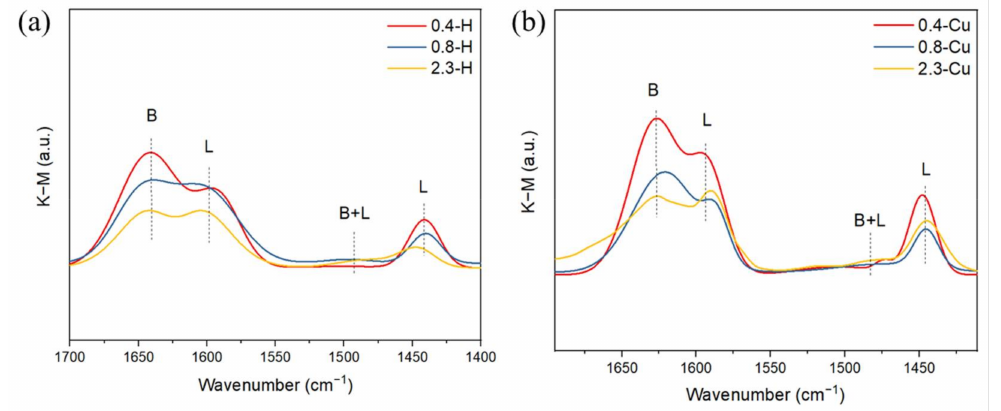
Figure 8. Pyridine-chemisorbed IR spectra of (a) H/SSZ-13 and (b) Cu/SSZ-13 with different crystal sizes before Na